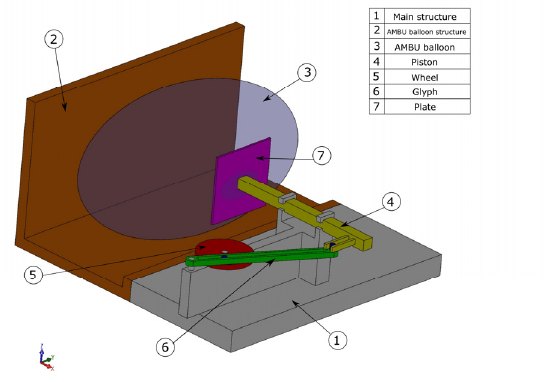
Figure 1. Virtual prototype of the emergency mechanical ventilator